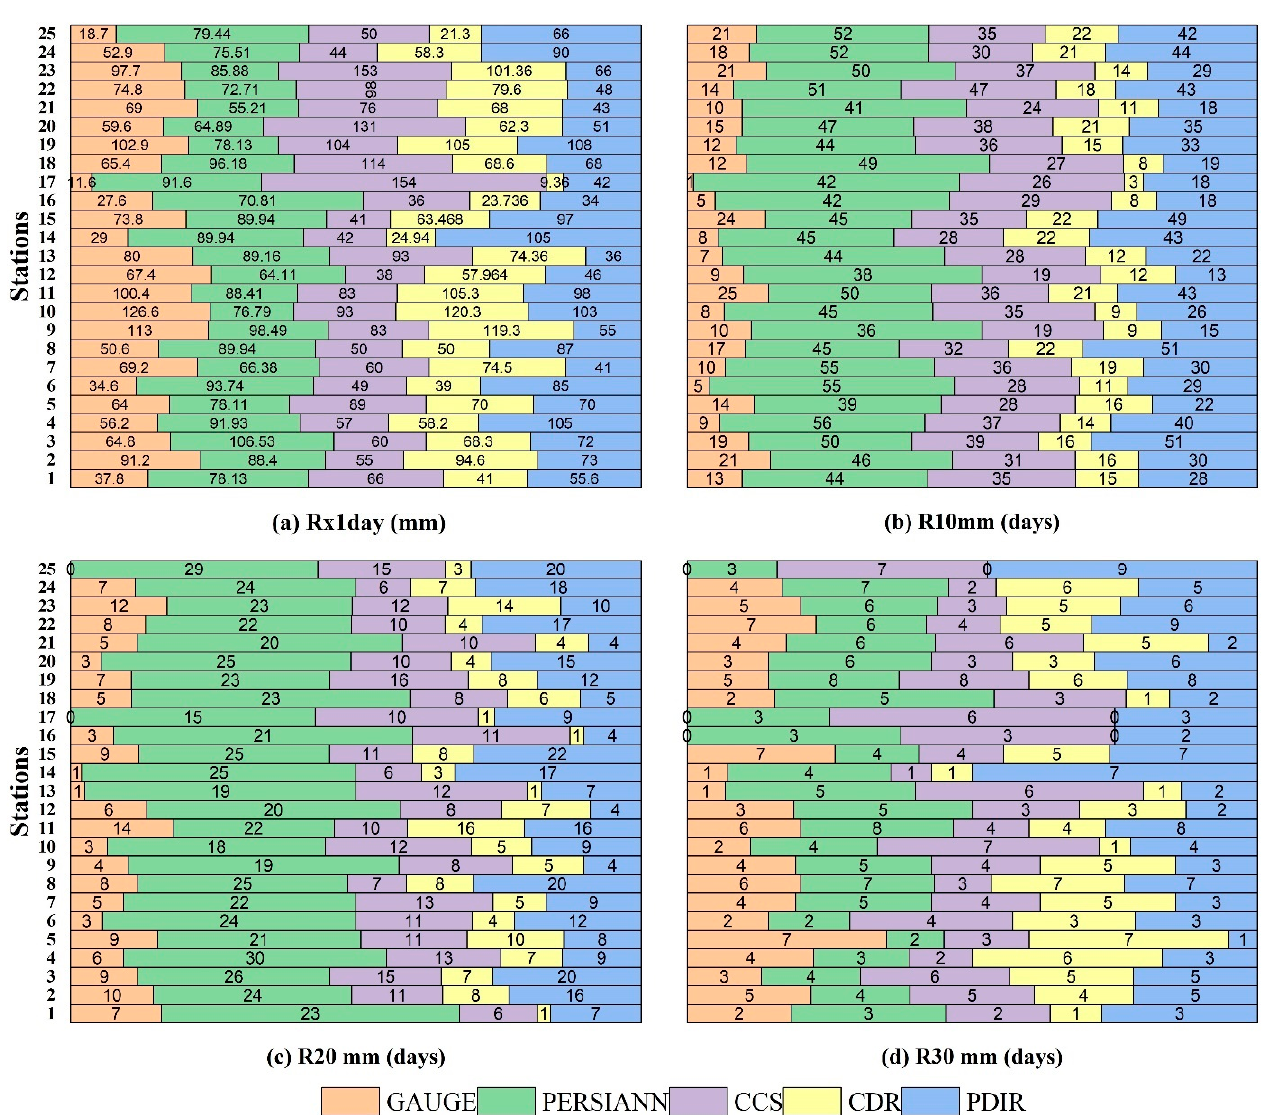
Figure 8. Climate indices comparison between the rain gauge observations and PERSIANN satellite products. ( a ) R × 1 day (mm) values for gauge vs. satellite products. ( b – d ) The same for R10, R20, and R30 mm.